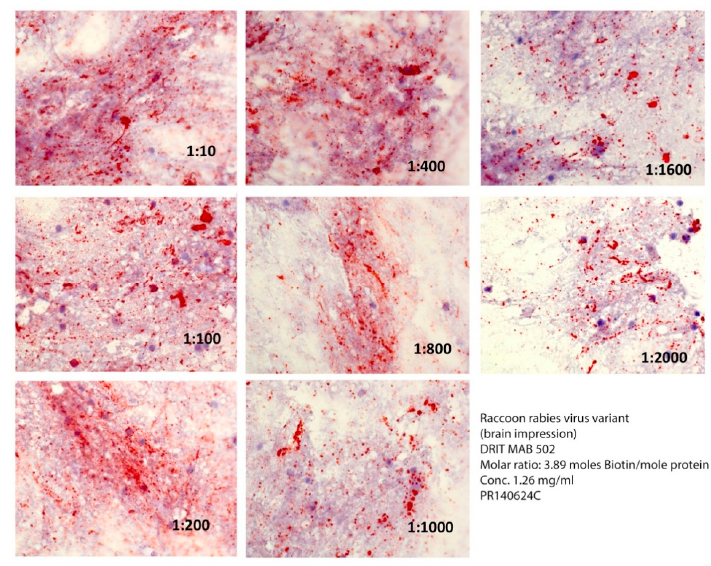
Figure 2. Comparative reactivity of serial dilutions of the DRIT MAB 502 at a ratio of 3.9 moles of biotin per mole of protein against a raccoon rabies virus variant.